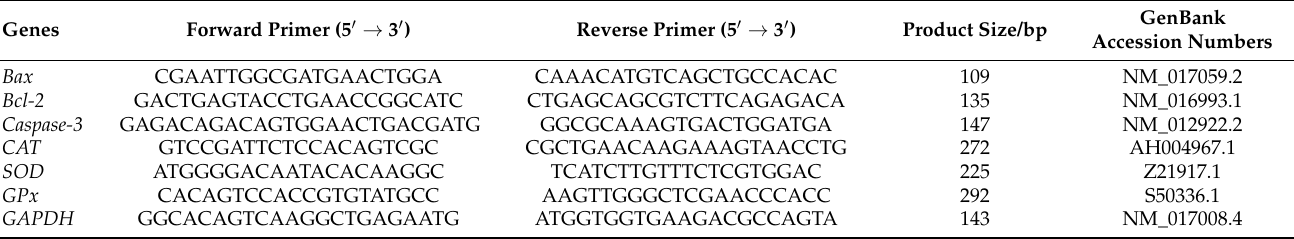
Table 1. Oligonucleotide primer sequences used for real-time